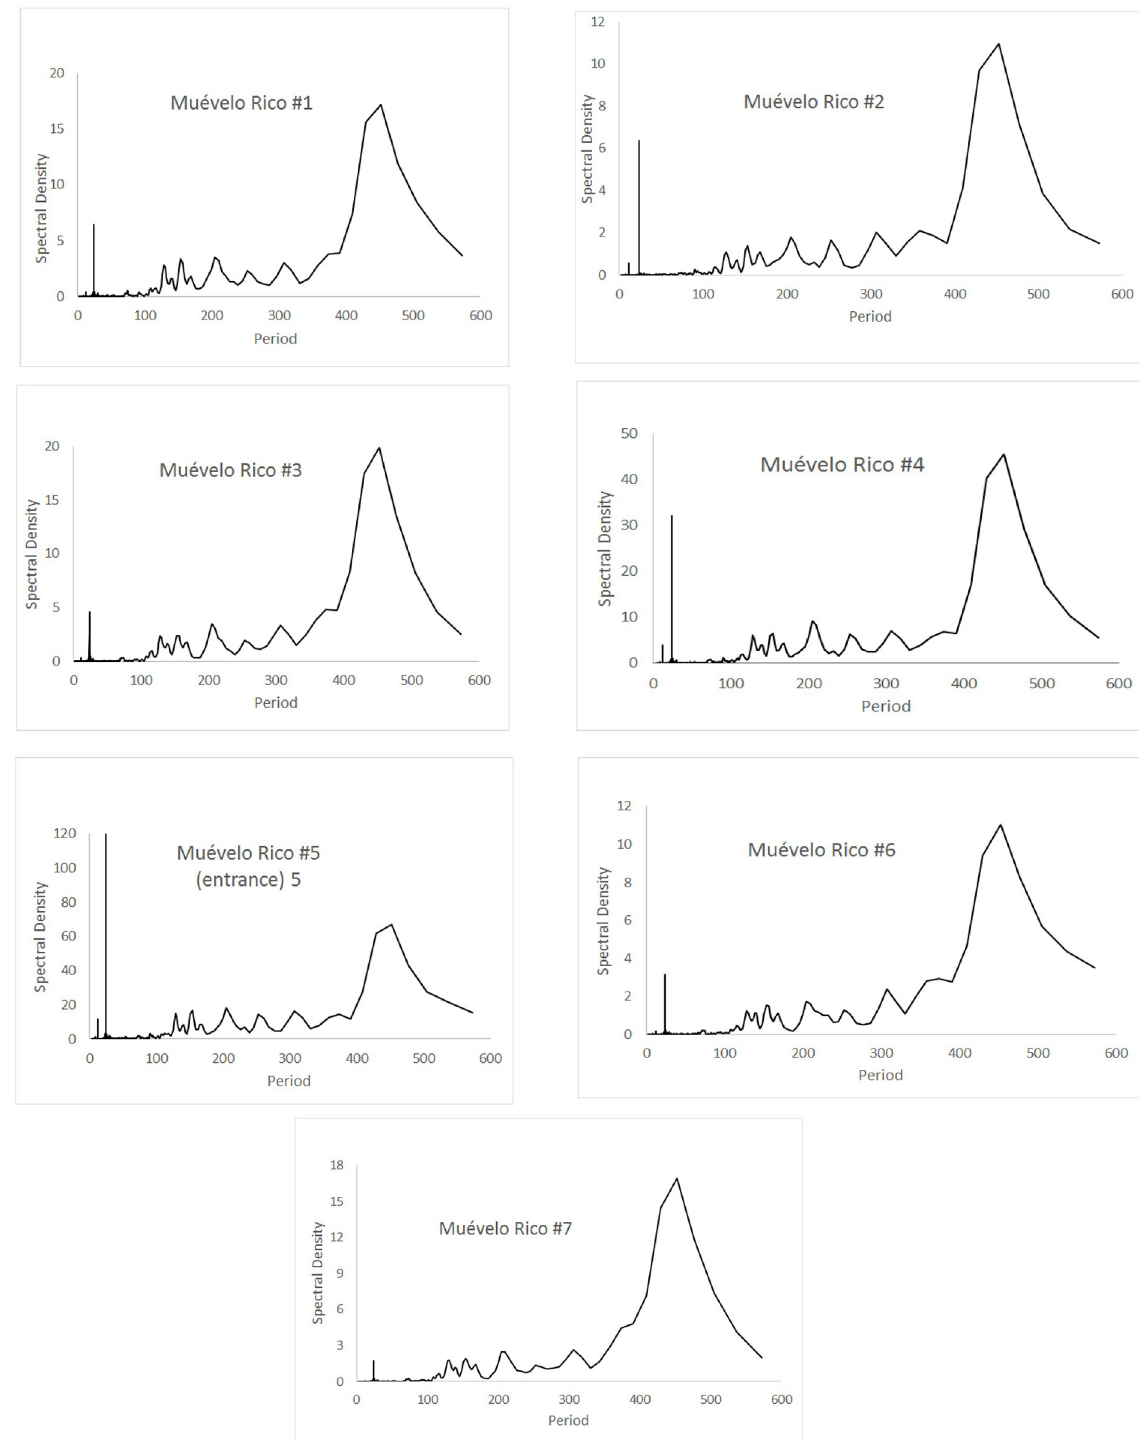
Fig 8. Spectral densities of temperature at the Mue´velo Rico sampling stations. Note that the scale of the y-axis is different for different stations. Period is measured in hours.